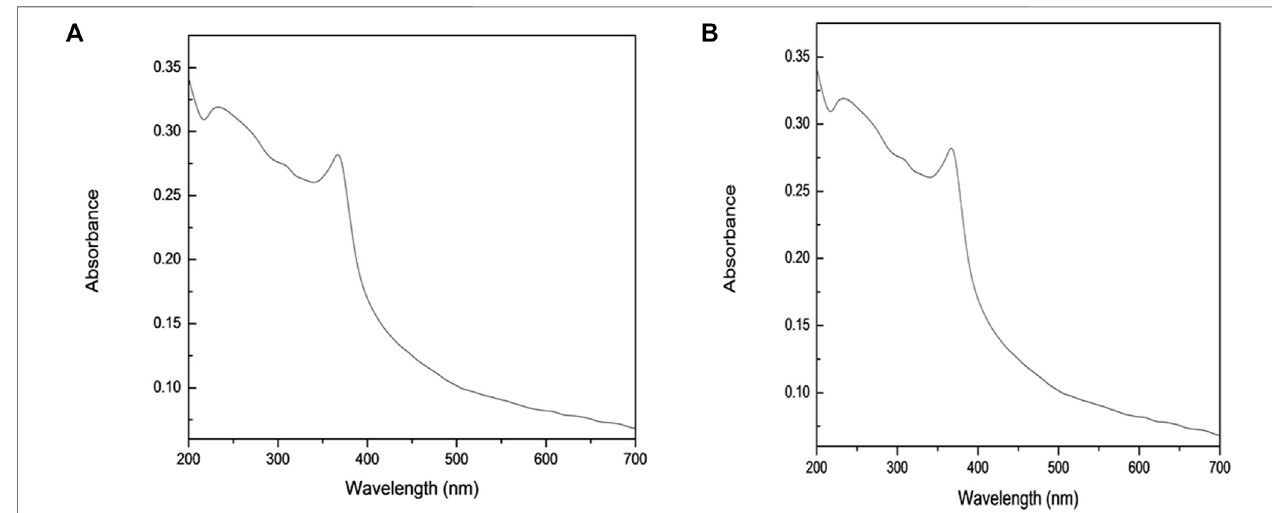
FIGURE 5 | UV-Vis absorption spectra of an aqueous solution of (A) synthesized and (B) commercial ZnO.